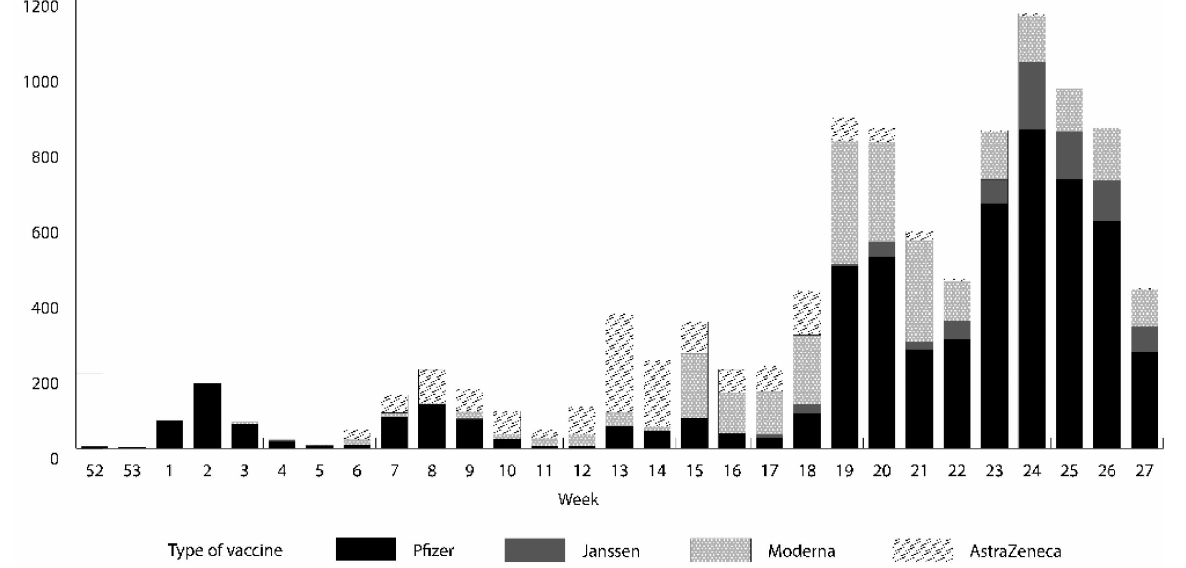
Figure 1. Number of vaccinated people living with HIV in Catalonia by manufacturer and